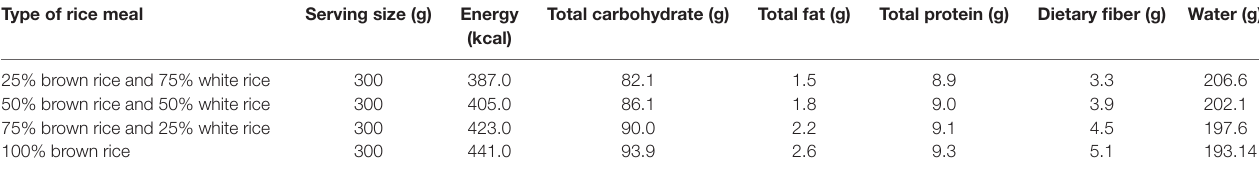
TaBle 2 | Nutrient content of cooked rice